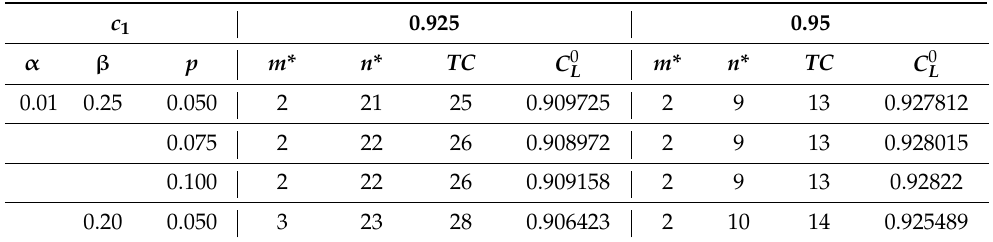
Table 2. The optimal ( m *, n *), total cost TC and critical value for c 1 = 0.925, 0.95, α = 0.01, 0.05, 0.1, β = 0.25, 0.20, 0.15 and p = 0.05, 0.075, 0.1 under m 0 = 20, L = 0.05 and c 0 =